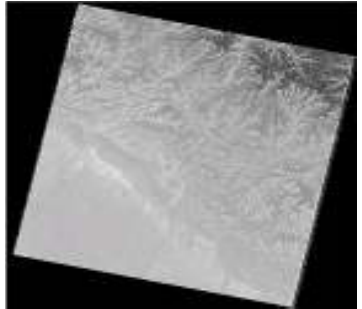
Figure 2.ASTER, 2001 band 12 Image of study area